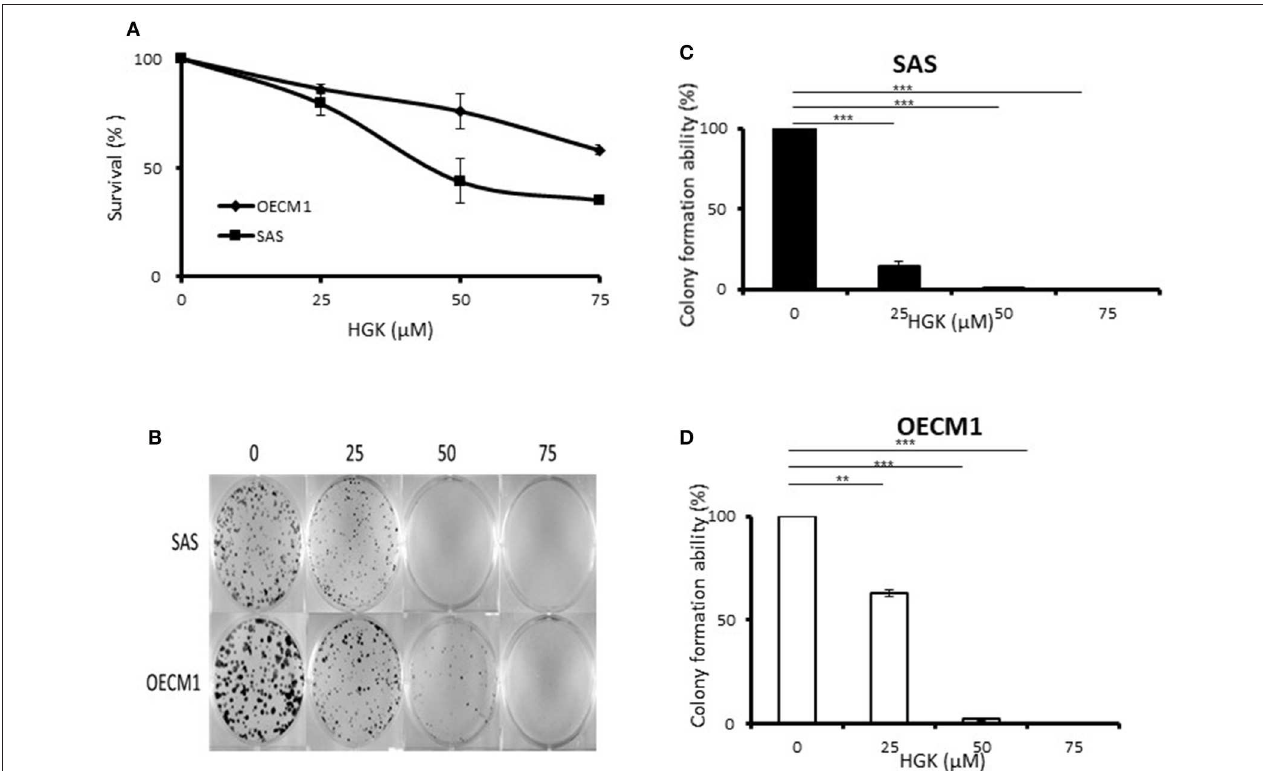
FIGURE 1 | Effects of HGK on the cell survival assay and colony formation of SAS and OECM1 cells. SAS and OECM1 cells were treated with HGK for 24h in different concentrations (0, 25, 50, 75 µ M). (A) MTT assay (B) The images showing colony formation assay in two cancer cells treated with HGK. (C) The quantitative analysis of colony numbers in SAS cells (D) in OECM1 cells. ** P < 0.01 and *** P <